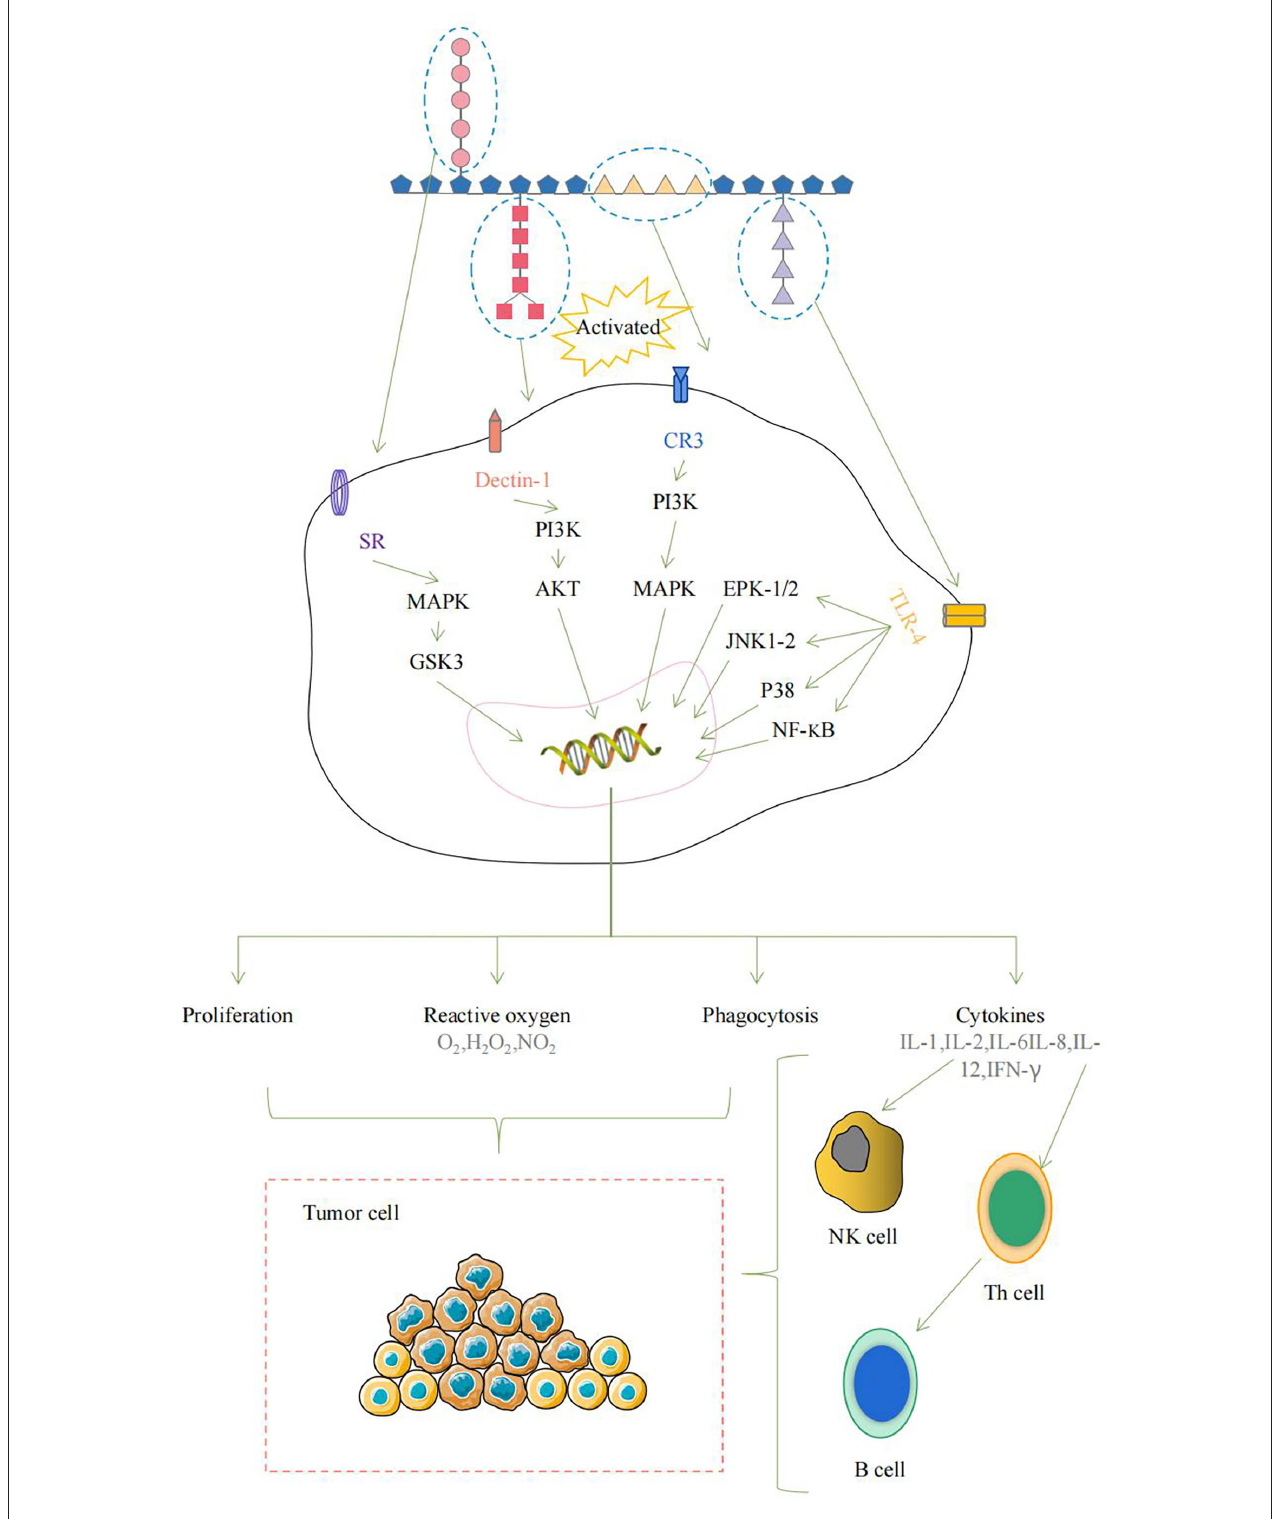
FIGURE 1 | The schematic diagram of the immune system activated by Marine algae polysaccharides after interaction of several molecular events.